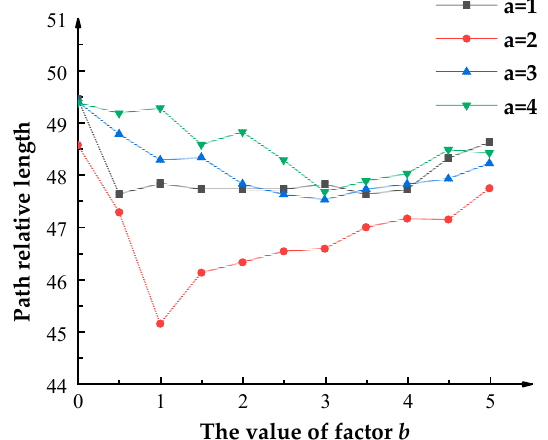
Figure 6. Relative length of paths with different parameters.